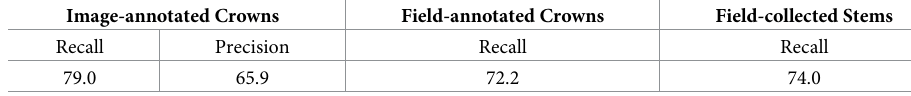
Table 3. Benchmark evaluation scores for the DeepForest python package.